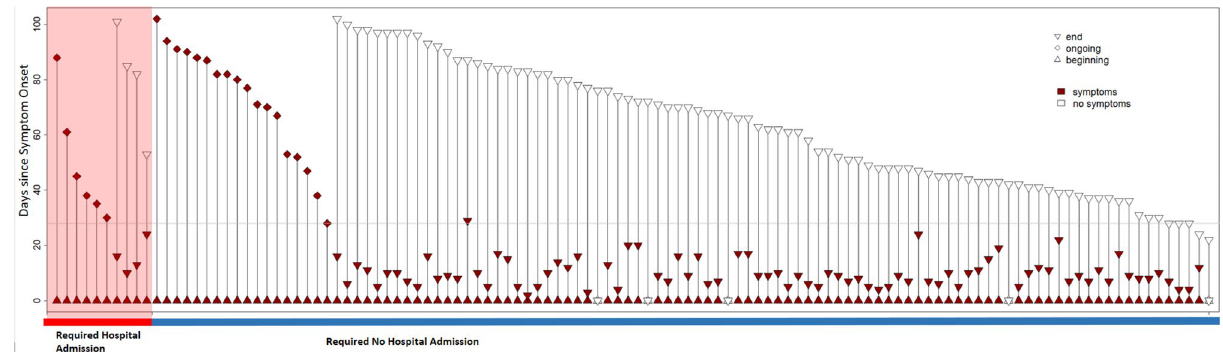
Figure 2. Follow-up day and symptom duration for each patient. Grey horizontal line represents threshold for persistent symptoms (28 days). Five patients were asymptomatic (symptom start and end at day